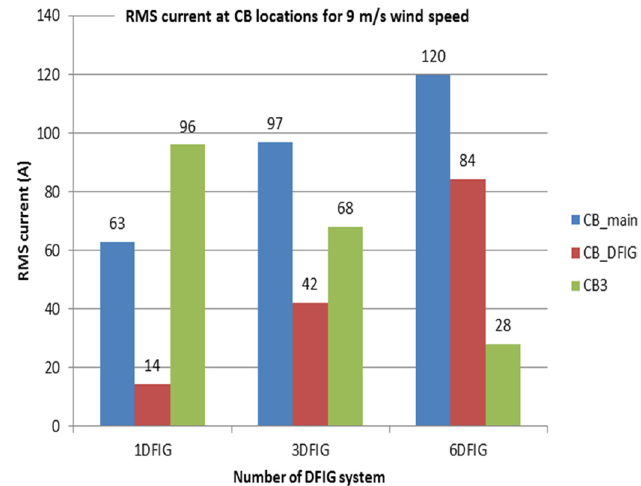
Figure 2. Bar chart representing the variation in loading current at the DFIG system.